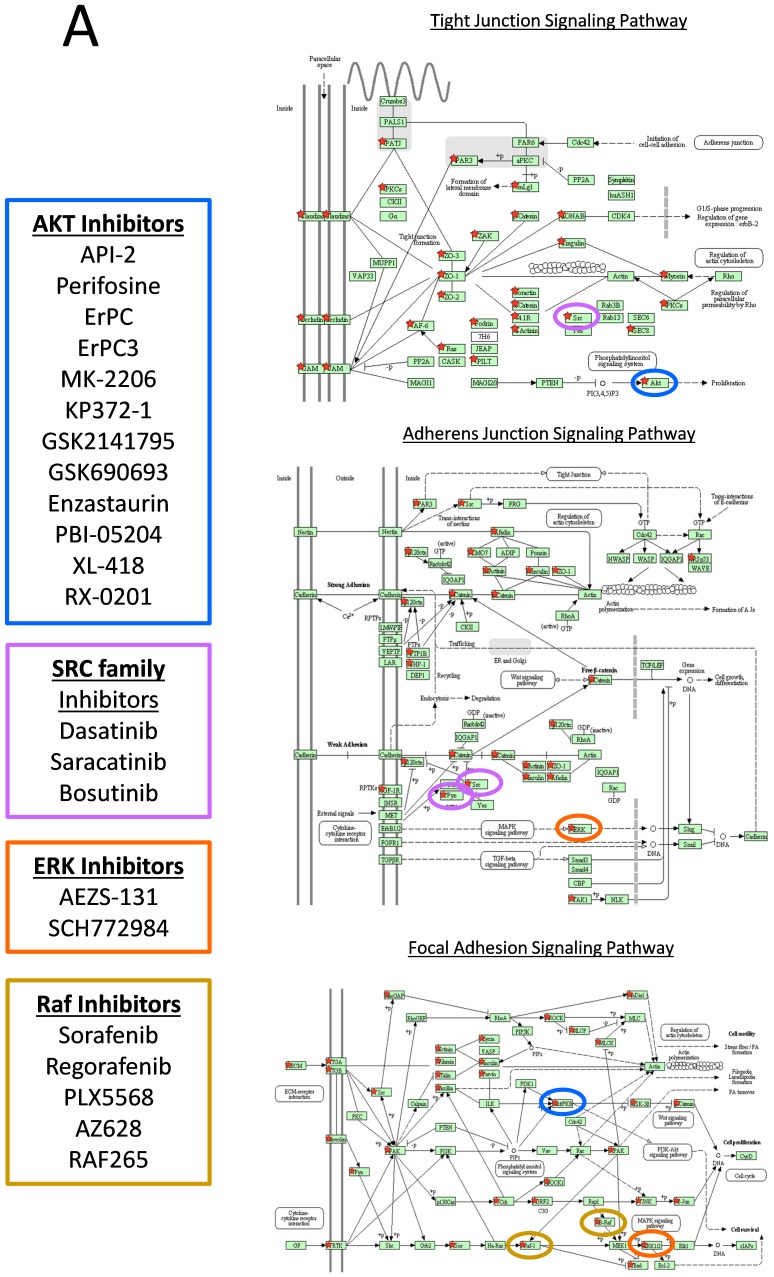
Signaling pathways highly modulated in pancreatic cancer.This schema summarizes all proteins identified as phosphorylated from the following KEGG signaling pathways; Tight Junction, Adherens Junction and Focal Adhesion. Red stars indicate those proteins identified as phosphorylated in any of 12 cases. Proteins highlighted by coloured circles are known drug targets.